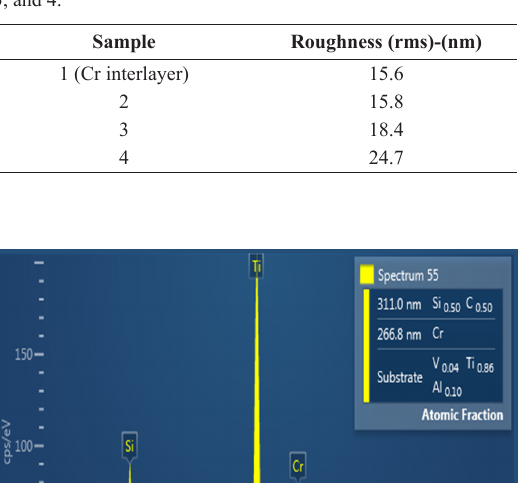
Table 3. Thickness of the films.